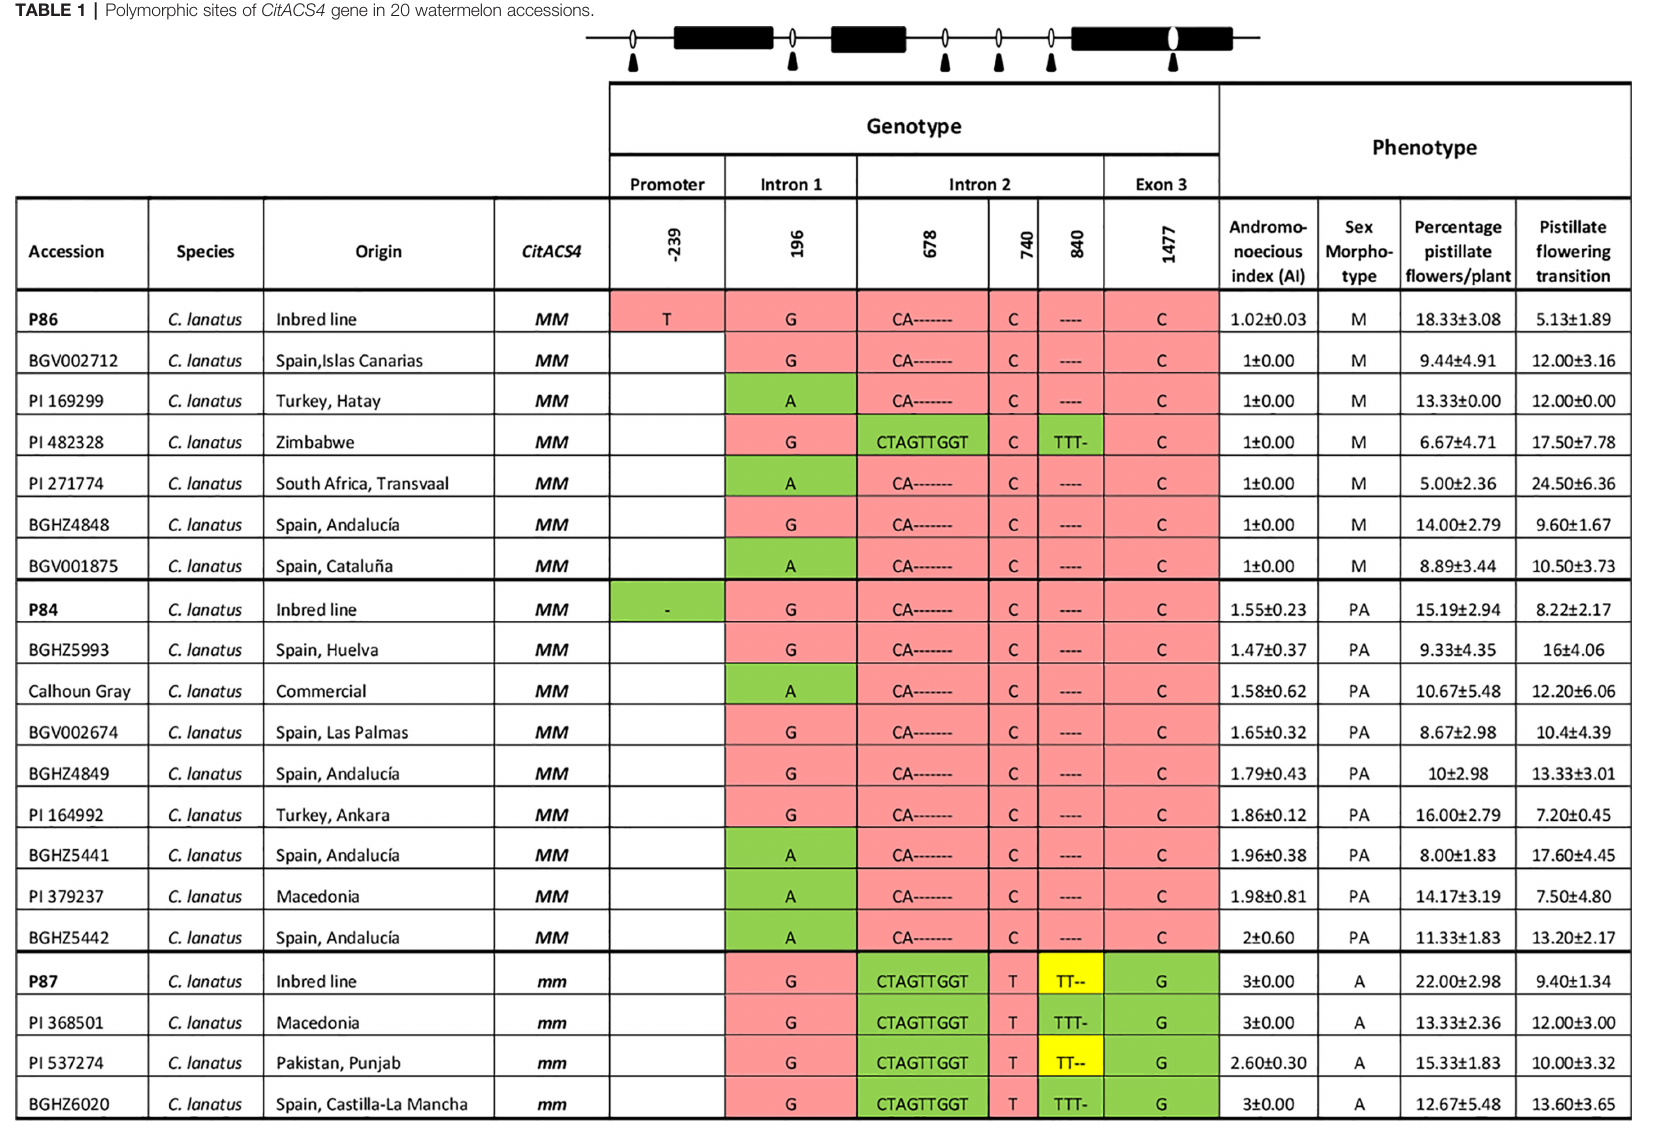
The top shows the structure of the gene, and the identi fi ed polymorphic sites. The M and m alleles are de fi ned by the polymorphism at position 1,477 in the third exon. The sex phenotypes of each accession are also indicated. Pink, green, and yellow boxes indicate the nucleotide variants in the different accessions. The polymorphic site (indel) in the promoter was only analysed in the P84 and P86 parental inbred lines. M, monoecious; A, andromonoecious; PA, partially